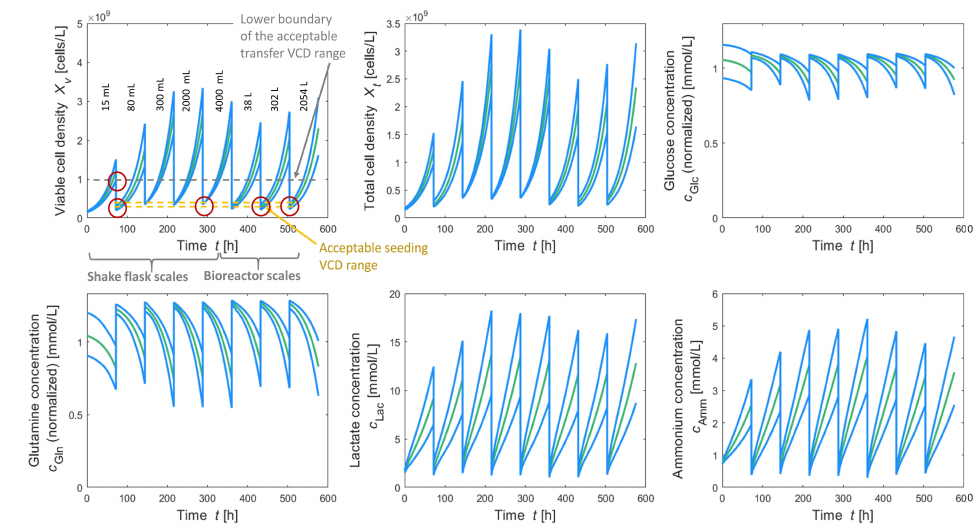
Figure 7. Reference (non-optimized) seed train showing viable and total cell density, as well as substrate (glucose and glutamine) and metabolite (lactate and ammonium) concentrations over time, based on a reference configuration setup for 5 shake flask scales using passaging intervals of 72 h each. The green lines represent the mean time course and the blue lines show the corresponding 90%-prediction band (5%- and